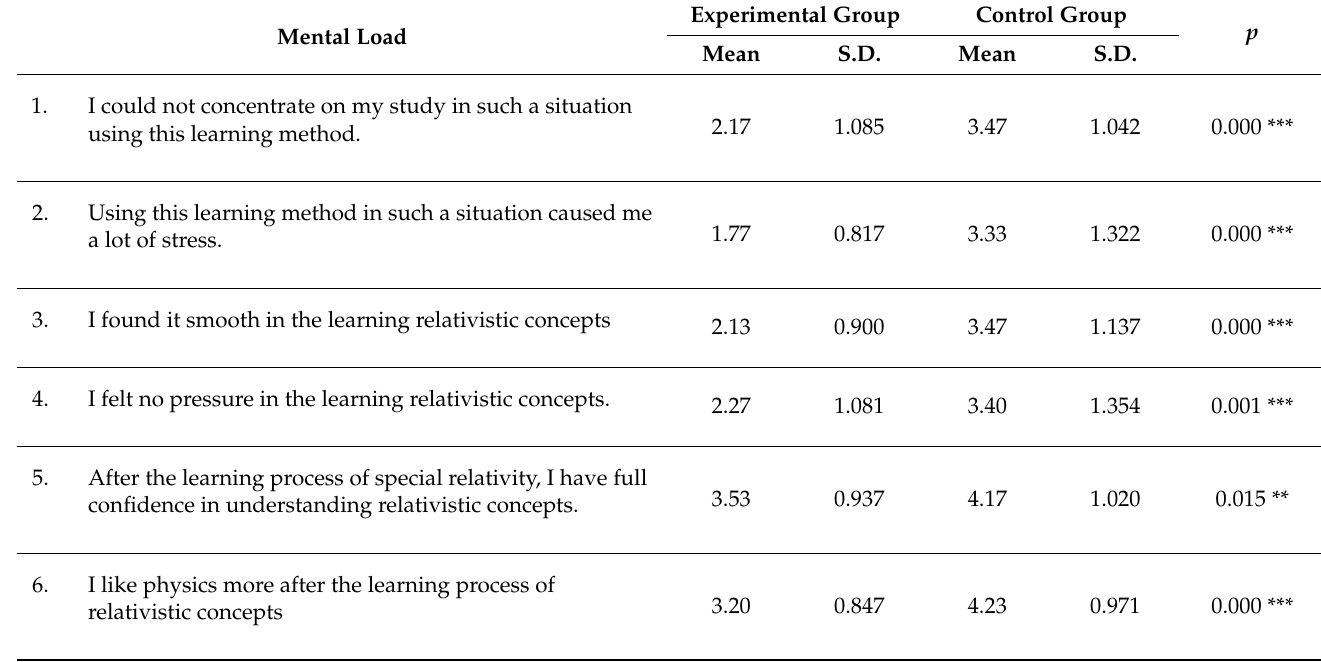
Table 8. Mean, standard deviation, and significance of “mental load” scores for both